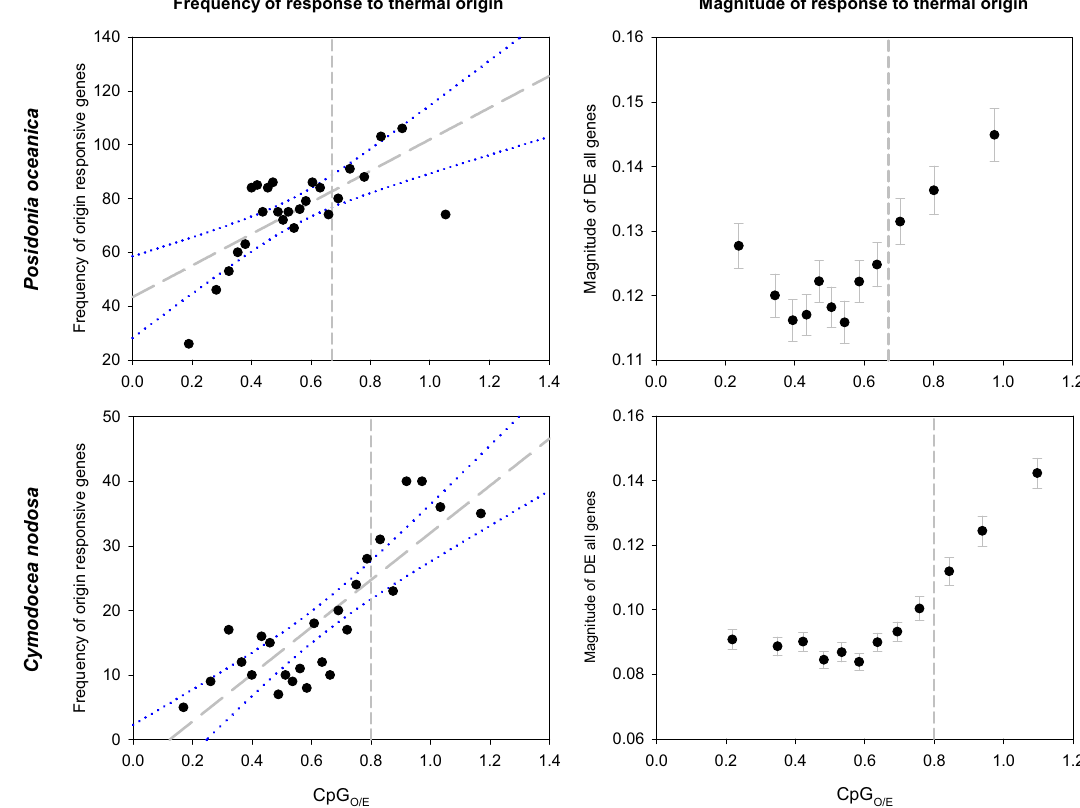
Figure 3. Relationship between CpG O/E and gene responsiveness associated to the thermal origin of P. oceanica (upper panels) and C. nodosa (lower panels) plants. Frequency of plant origin flexible genes (left panels): each data point represents the number of DEGs (FDR < 0.05) responding to the thermal origin of plants within each of the 25 CpG O/E bins and the mean CpG O/E for the bin. Magnitude of response to thermal origin of plants (right panels): magnitude of differential expression for each annotated gene. Magnitude points represent the log mean differential expression value and standard error of the genes divided in 12 bins. Dashed vertical lines represent the intersection of the two fitted component curves of the bimodal distribution of CpG O/E in each species. Solid grey lines and dotted blue lines represent the Pearson correlation line and the 95% confident intervals